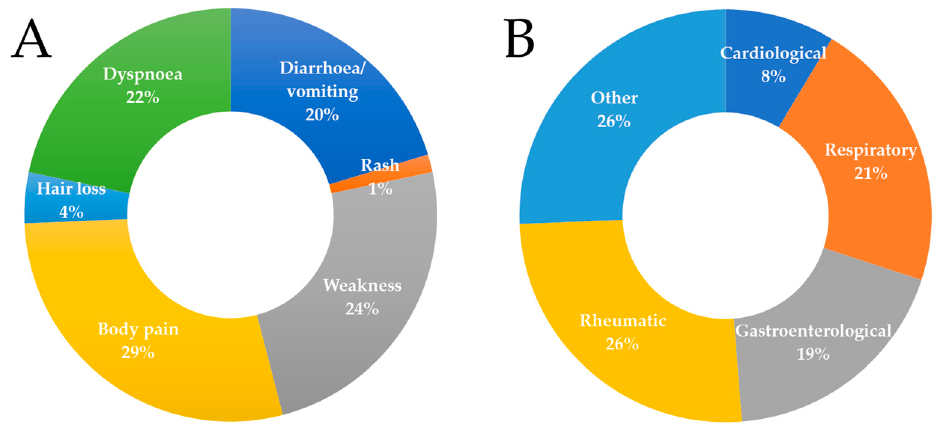
Figure 1. Symptoms associated with COVID-19 ( A ) and comorbidities present in the study group ( B ). Self-reported health before COVID-19 disease was good in 68.0% of respondents, average in 27.9%, and bad in only 3.4% (no data—1 person). Before the disease, 70.7% of patients were physically active, with 34% of people exercising daily, 31.3% once or